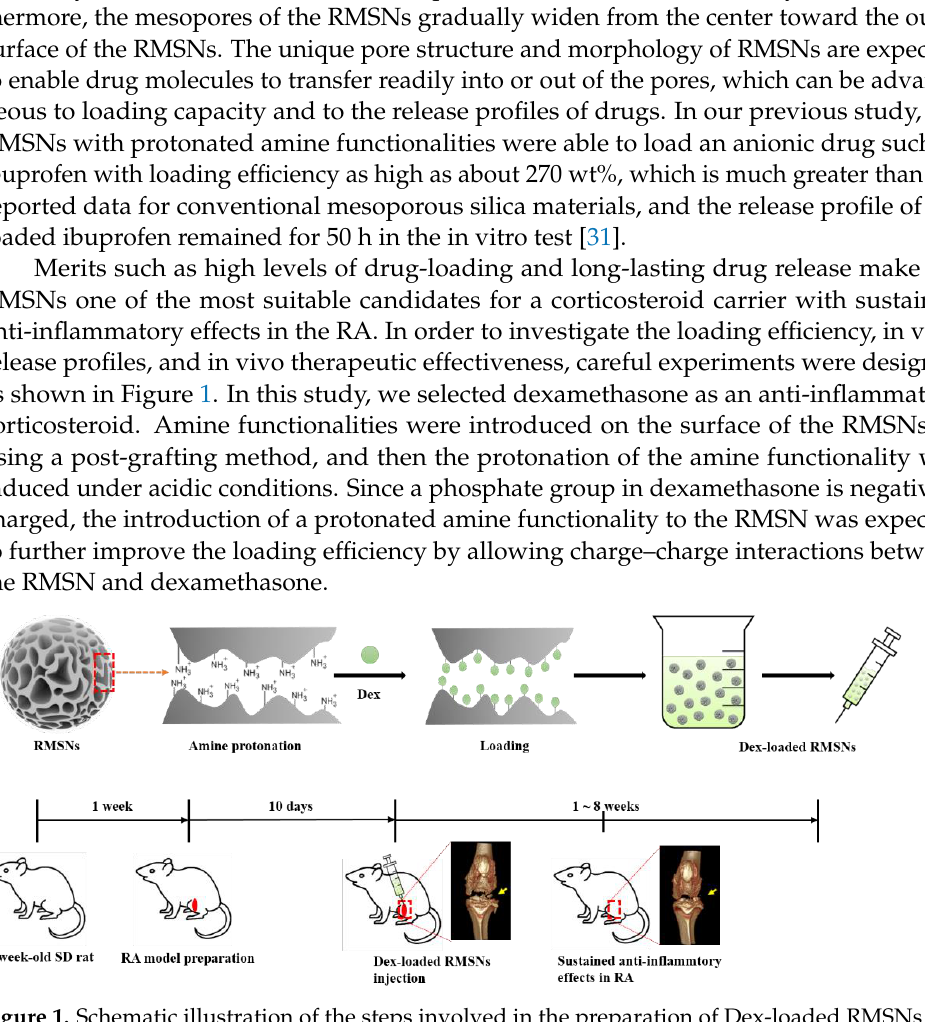
Figure 1. Schematic illustration of the steps involved in the preparation of Dex-loaded RMSNs ( A ); and, an experiment for sustained anti-inflammatory effects in an animal model of RA using Dex- loaded RMSNs ( B ).